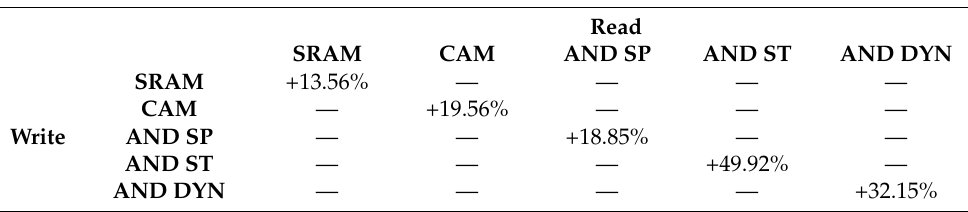
Table 8. Percentage differences of the write and read energy-delay products in each memory. Each value corresponds to the increase, expressed in percentage, in the energy-delay product of the memory on the corresponding row with respect to the one of the memory on the corresponding column. The data are extracted from Table